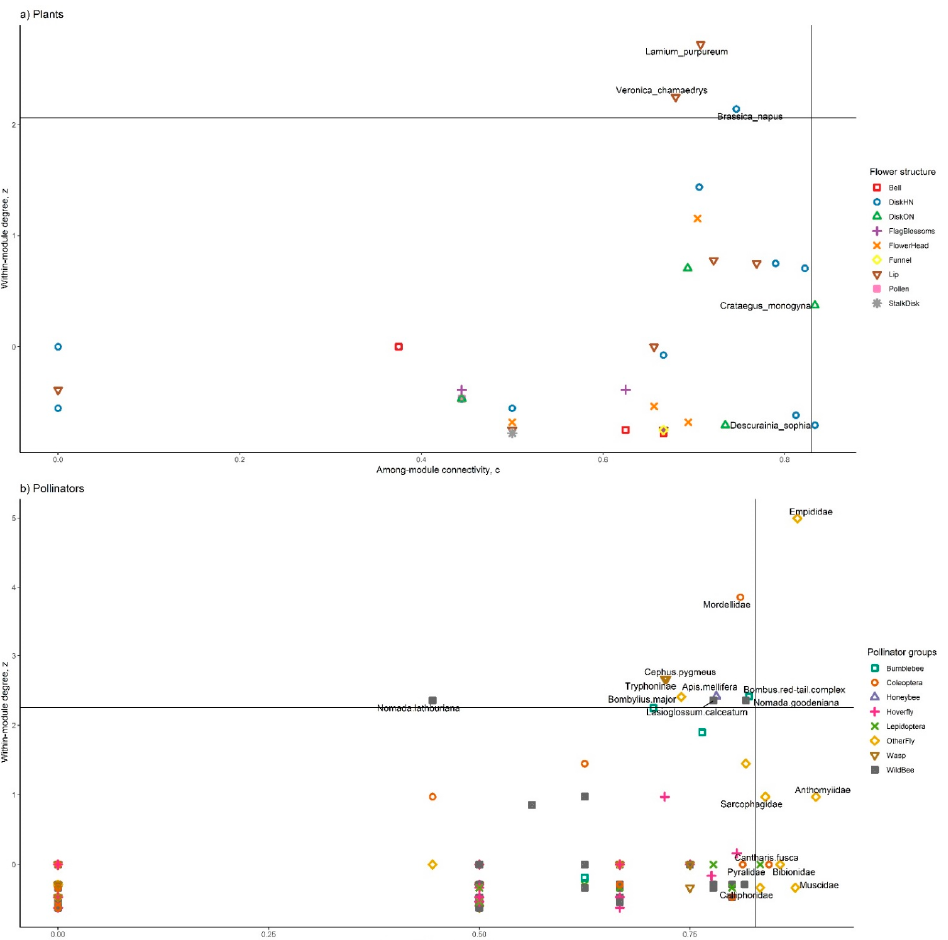
Figure 6. Distribution of ( a ) plants and ( b ) pollinators according to their network role. Each point represents a species, colors and shapes represent functional groups. Species with high c- and/or z-values are named. Threshold lines (95% quartiles) are shown.